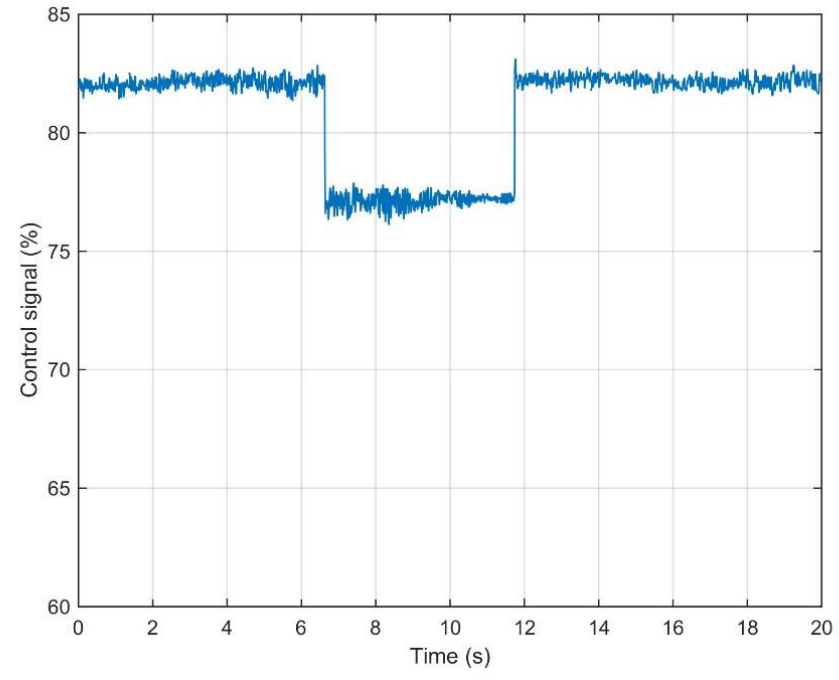
Figure 14. Control signal evolution.